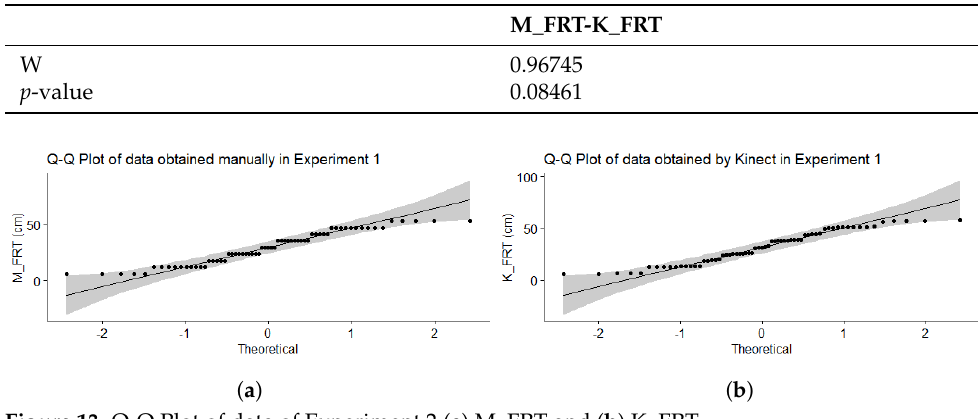
Figure 13. Q-Q Plot of data of Experiment 2 ( a ) M_FRT and ( b )